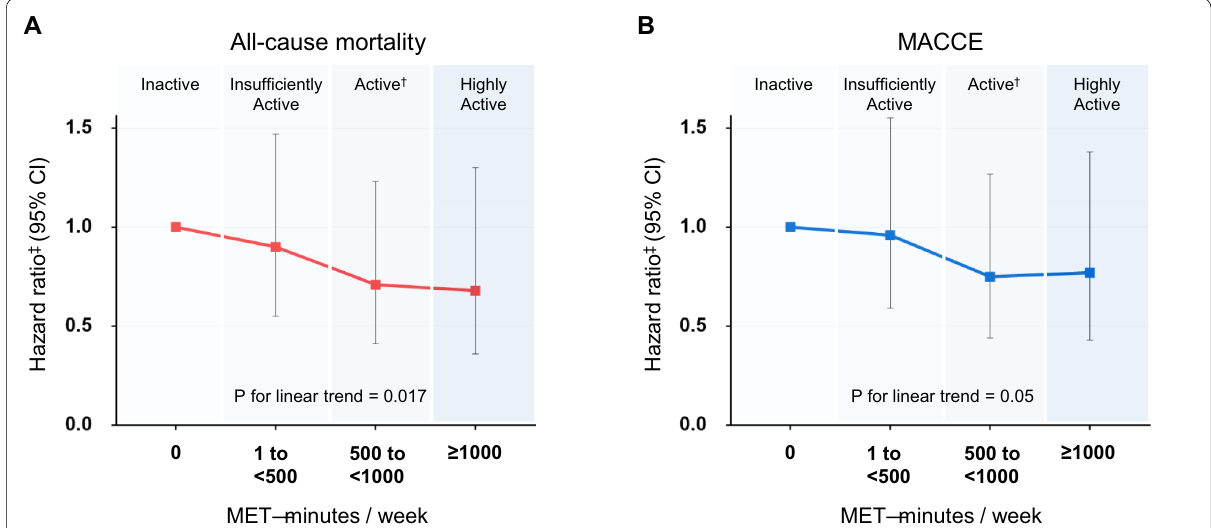
Fig. 1 Multivariable adjusted relative risk of all‑cause mortality ( A ) and MACCE ( B ) according to physical activity levels as classified in the Physical Activity Guidelines. † Minimum key guidelines target range in Physical Activity Guidelines for Americans by the U.S. Department of Health and Human Services (2018): Doing the equivalent of 500–1,000 MET‑min/week of physical activity. ‡ Multivariable adjusted hazard ratio: age, sex, body mass index, heart failure, hypertension, diabetes, previous myocardial infarction, prior stroke or transient ischemic attack, chronic kidney disease, dyslipidemia, smoking, and alcohol intake. CI, confidence interval; MACCE, major adverse cardiac and cerebrovascular events; MET,